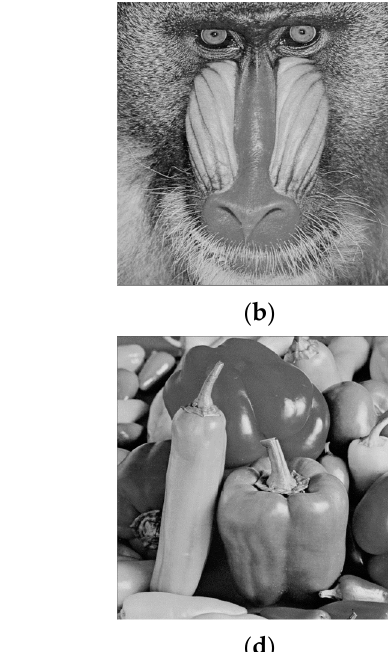
Figure 6. An example of the extraction process in which the 4×4-pixel block is divided into 4 sub- blocks.